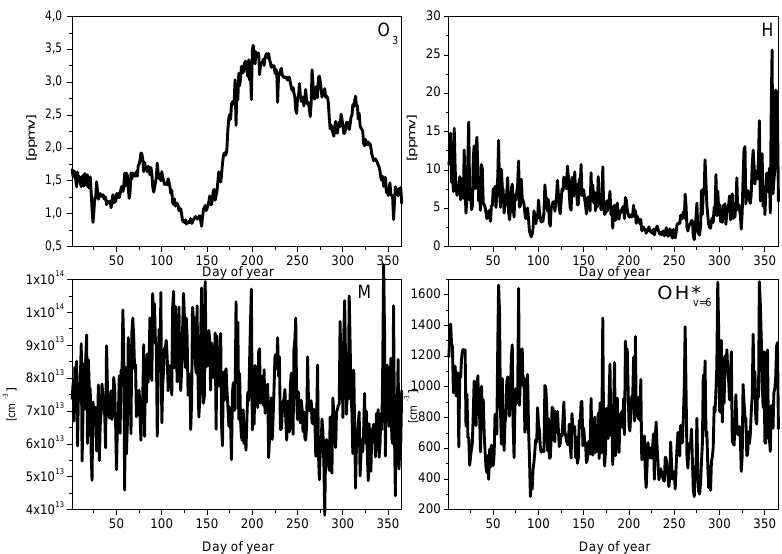
Figure 14. Explicit factors of influence on the OH ∗ number density according to Eq. (2) at height of OH ∗ maximum at 51.25 ◦ N in 2009.